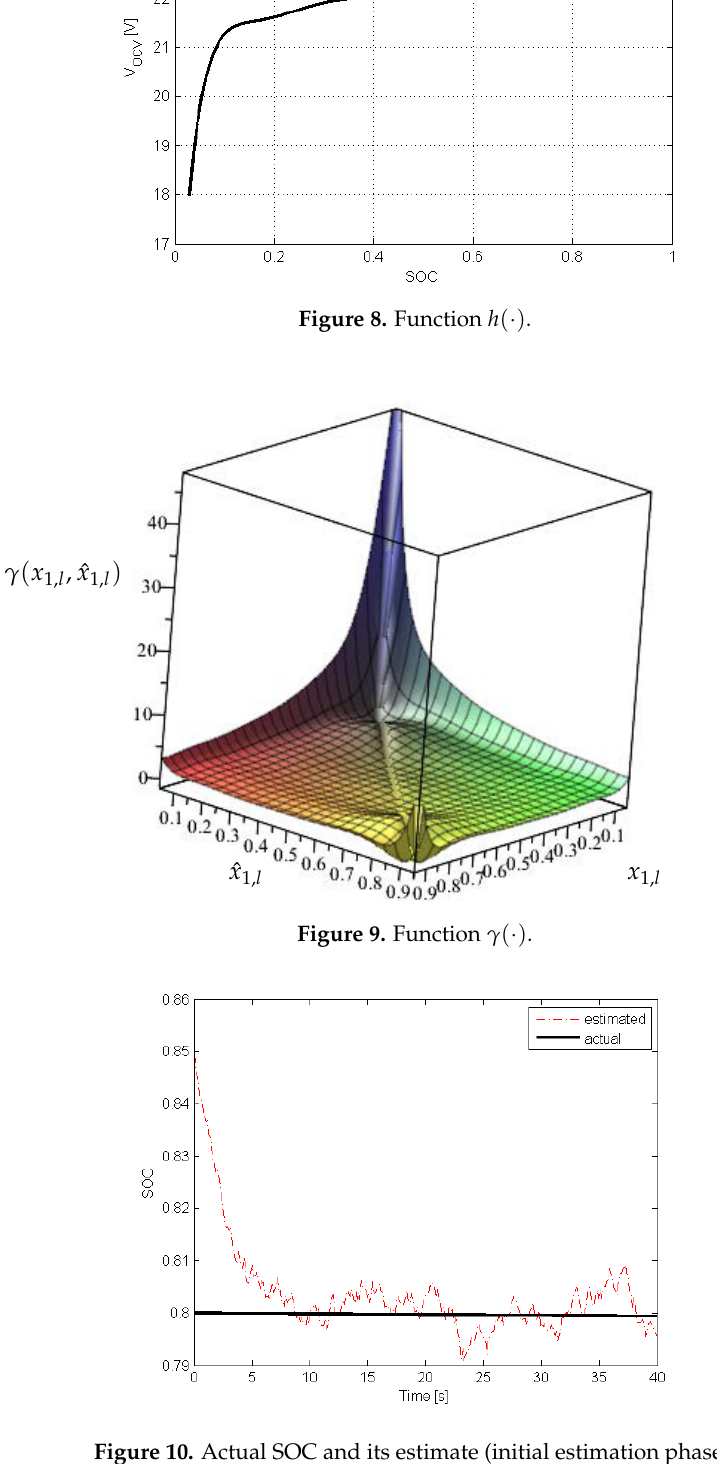
Figure 10. Actual SOC and its estimate (initial estimation